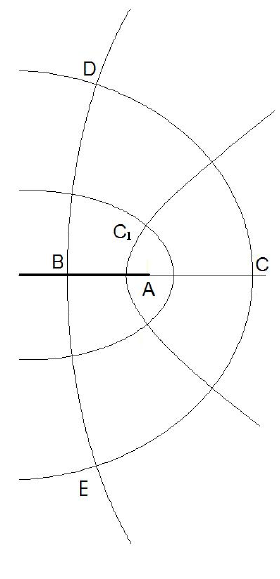
Figure 10: Focus A of the ellipse.